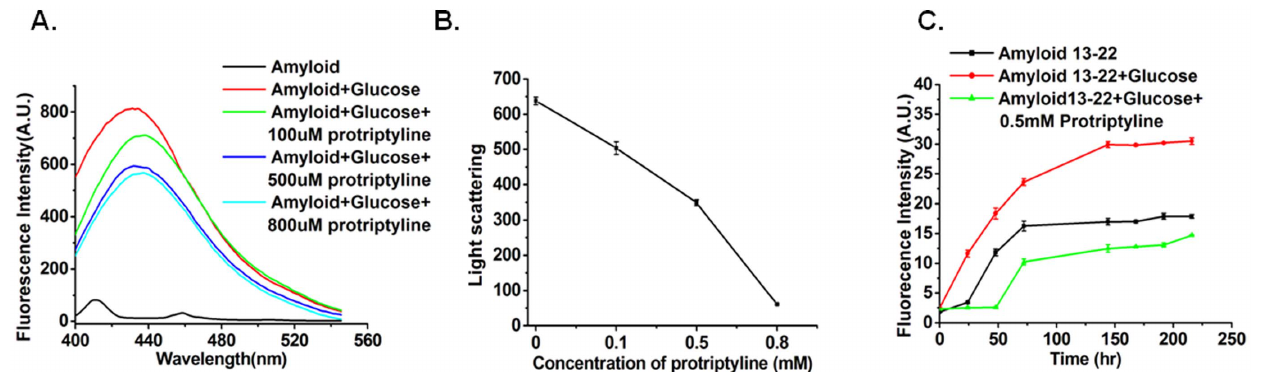
Figure 6. Protriptyline inhibits glycation. A. Fluorescence emmission of A b and glycated A b in presence of various concentration of protriptyline B . Light scattering and C . Kinetics of amyloid aggregation by Thioflavin T of A b 13–22 and glycated A b 13–22 in the absence and presence of protriptyline.